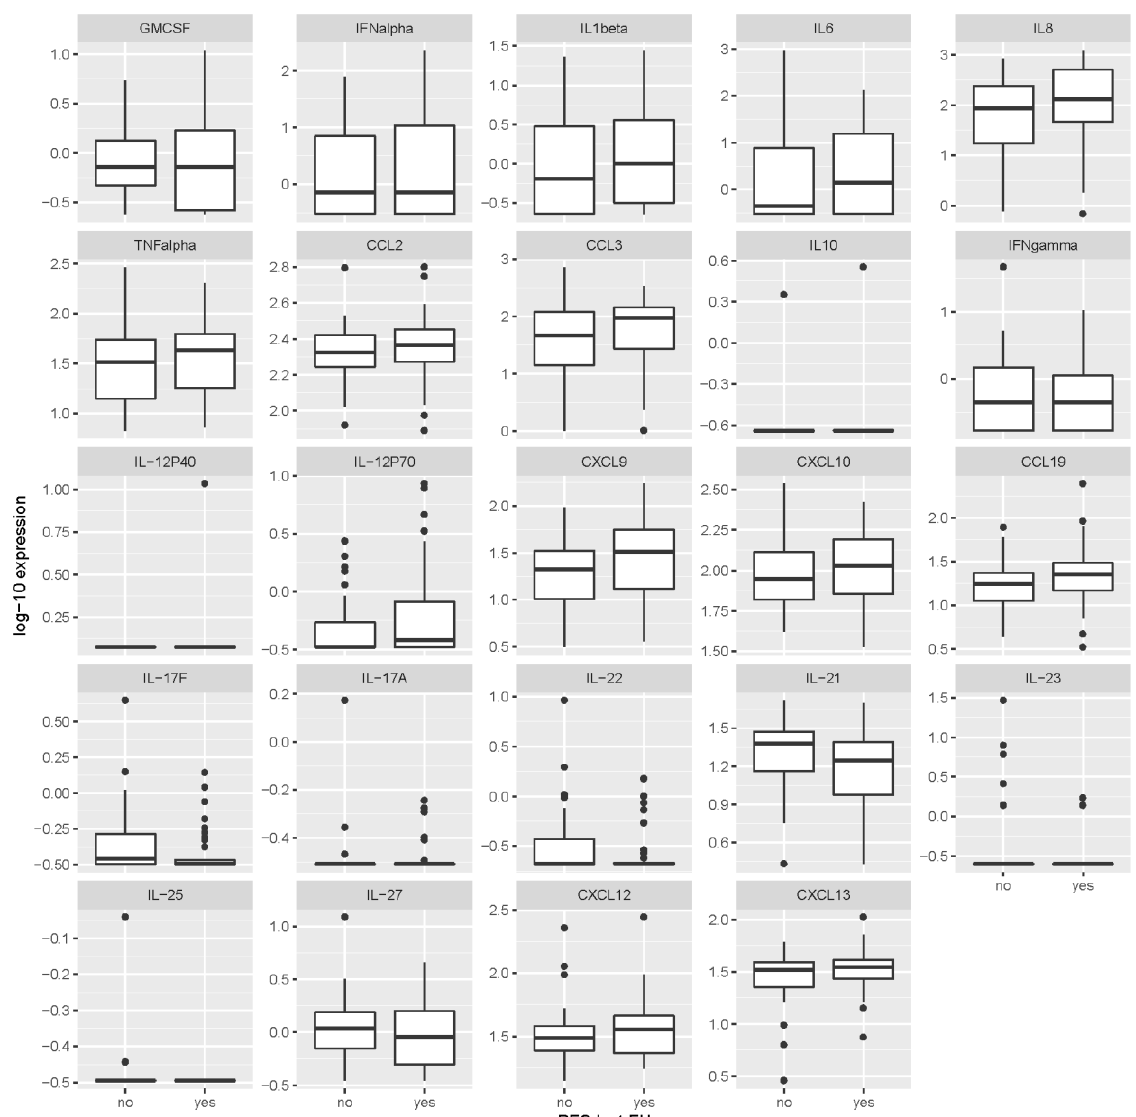
Figure 4. Levels of cytokines / chemokines in serum obtained from patients 2–7 years after tick-borne encephalitis according to the presence or absence of post-encephalytic syndrome at the same time point. Concentrations are in ng / mL for IL-17F, IL-23, IL-25 and IL-27, and in pg / mL for all other inflammatory immune mediators. PES last FU = post-encephalitic syndrome present at last follow-up visit (at the time point when levels of cytokines / chemokines were determined).